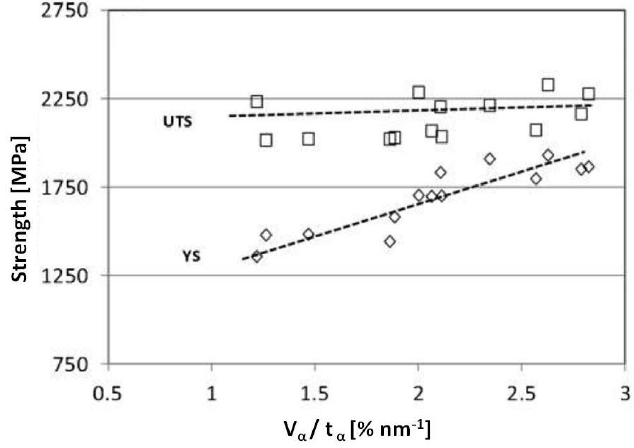
Figure 3. Ultimate tensile strength ( UTS ) and yield strength ( YS ) of different nanostructured bainites as a function of the ratio V α / t α . Adapted from reference [42].